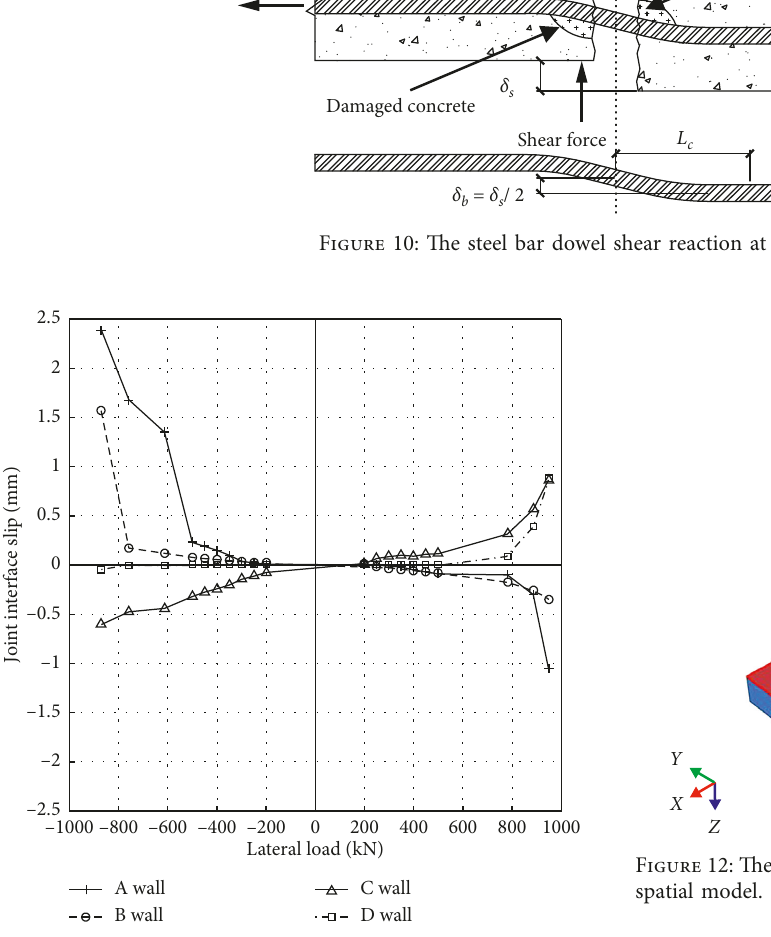
Figure 11: Lateral load-slip curves for precast shear walls.